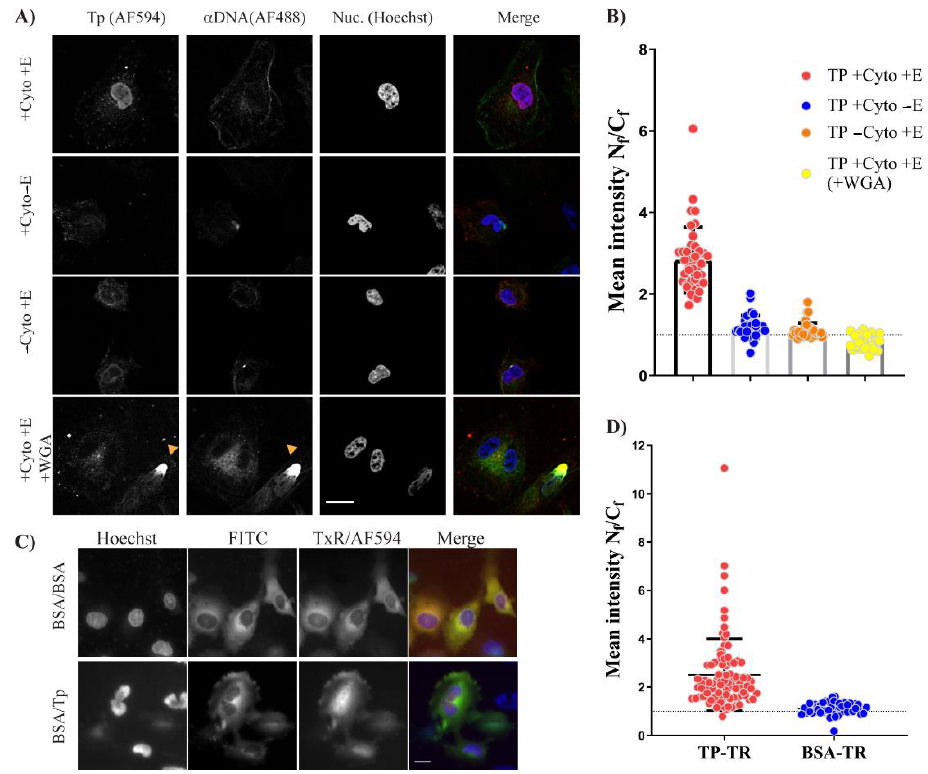
Figure 6. TP – Trx is translocated into the nucleus using active transport that requires energy. ( A ) TP – Trx labelled with AF594 was incubated with cells permeabilised with digitonin for 30 min as described in the Methods section. Images were taken with laser confocal microscopy using the same imaging criteria across all conditions. AF488 (αDNA) was used to determine whether the nuclear membrane is compromised. The orange triangle shows an example of the compromised nucleus next to two cells with an uncompromised nuclear membrane. Those compromised nuclei were excluded from the analysis and calculations. E: energy; Cyto: rabbit reticulocyte lysate cytoplasm; WGA: wheat germ agglutinin. ( B ) Analysis of the mean fluorescence (AF594) intensity ratio (N f /C f ) from DPA experiments. Data collected from fluorescence images in ( A ) were analysed us- ing Image J as described in the Methods section and mean fluorescence intensities were plotted. The dotted line represents N f /C f of 1. Difference between conditions was analysed using ANOVA test with Tukey’s multiple comparisons as described in Table S7. Bars represent mean ± SD. N > 23. ( C ) Cytoplasmic microinjection of labelled TP–Trx–AF594 with BSA–FITC to serve as a cytoplasmic control. As an additional control, BSA–TxR was used instead of TP–Trx–AF594 and coinjected, cytoplasmically, with BSA–FITC. Images were taken approximately 30 min after microinjection of the proteins. ( D ) N f /C f ratios between TP–Trx injected compared to BSA control. Analysis of difference between the two conditions was conducted using Welch’s t–test with p –value < 0.0001. N > 50, mean ± SD. Scale bar = 10 µ